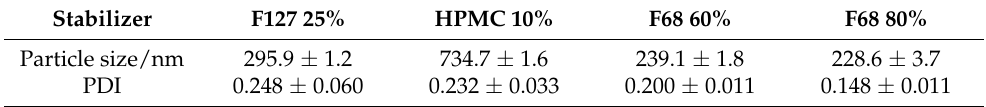
Table 1. Size and PDI information of the produced indomethacin nanosuspension batches. (The amount of stabilizer is given in w / w percentages with respect to the amount of drug).